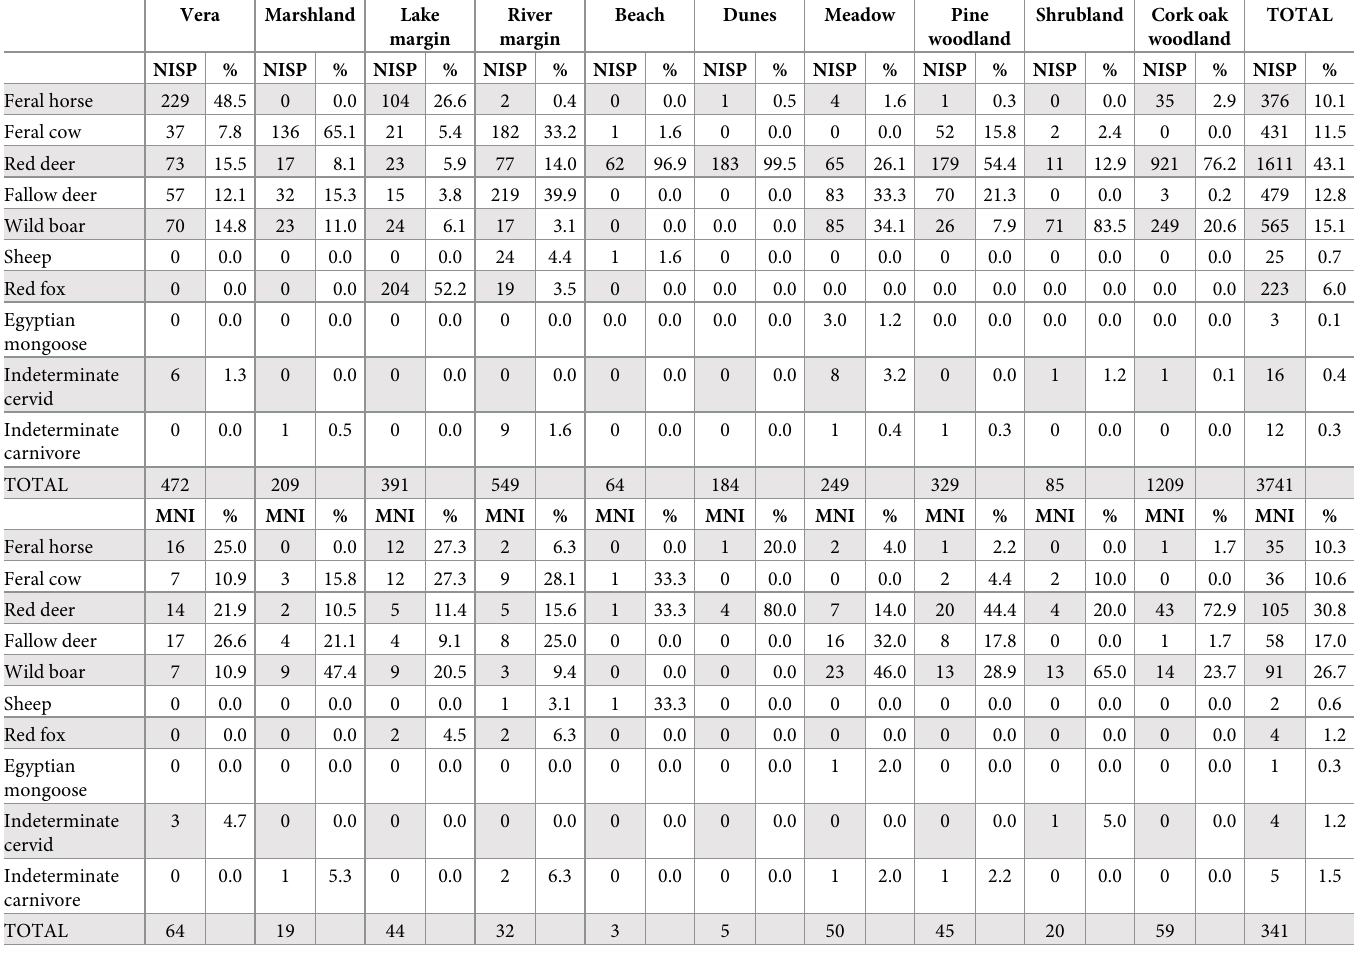
Table 4. Species composition of the death assemblages from Do ñ ana National